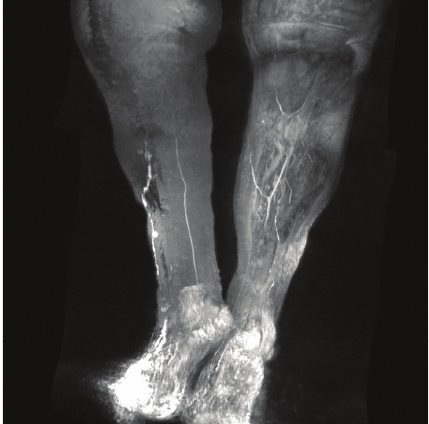
Figure 2: Two afferents superficial lymphatic vessels to the knee in MRL.